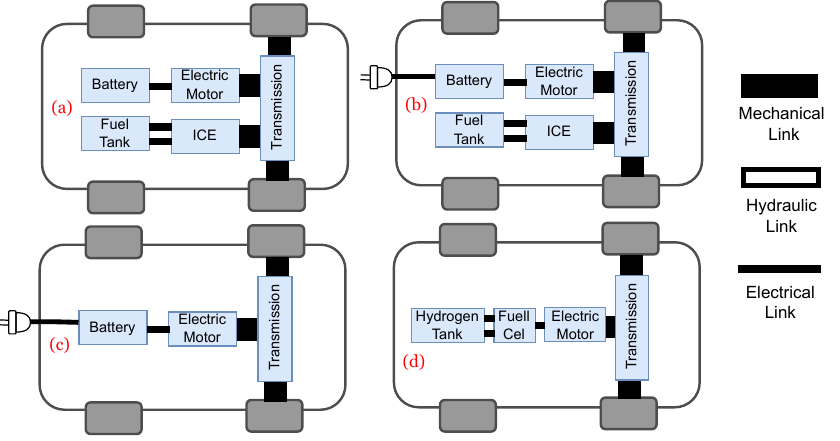
Figure 1. Basic structure of different electric vehicles (EVs) types. ( a ) Hybrid electric vehicle (HEV); ( b ) plug-in hybrid electric vehicle (PHEV); ( c ) battery electric vehicle (BEV); and ( d ) fuel cell electric vehicle (FCEV).